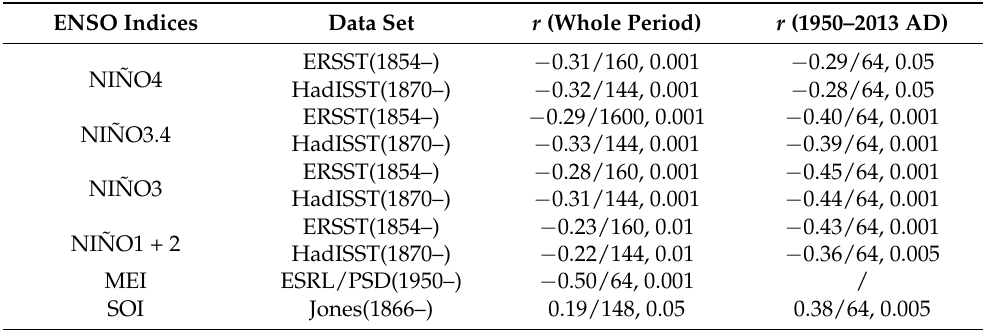
Figure 11. Spatial correlations between the reconstructed precipitation and SST. Table 1. Correlations between the reconstructed precipitation of June–July and NIÑO4, NIÑO3.4, NIÑO3, NIÑO1+2, MEI, and SOI indices at the same months.